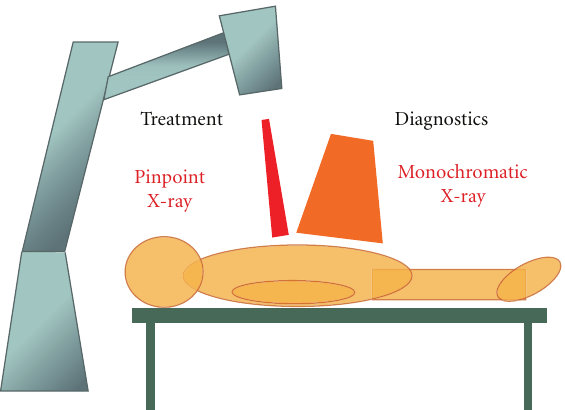
Figure 1: Schematic diagram of the future pinpoint X-ray therapy